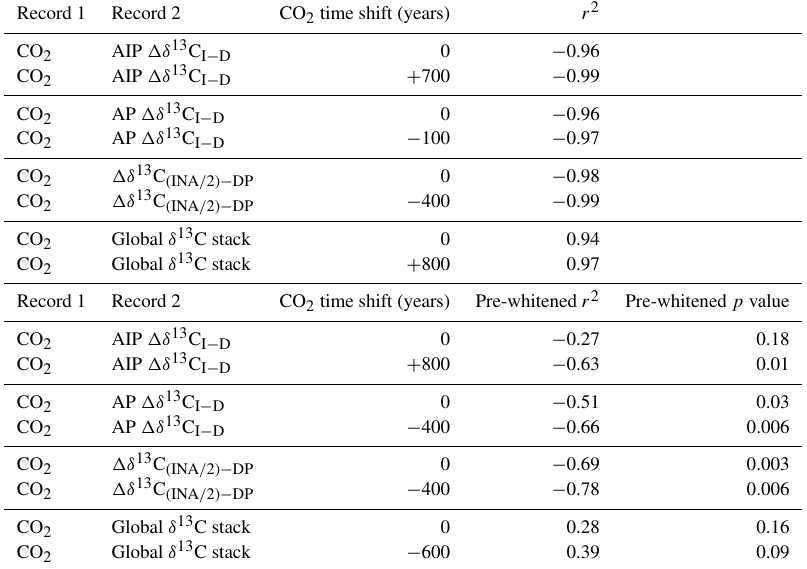
Table A2. Correlation coefficients and p values between records. The upper rows use the raw data, and the bottom rows use pre-whitened data to account for autocorrelated time series. AIP gradients include Atlantic, Indian, and Pacific regions, and AP gradients include only Atlantic and Pacific regions. To investigate possible leads/lags between records, we shift the atmospheric CO 2 record in 100-year increments relative to the δ 13 C stacks and, for brevity, list only the best correlations. All p values account for reduction in degrees of freedom due to pre-whitening and/or time